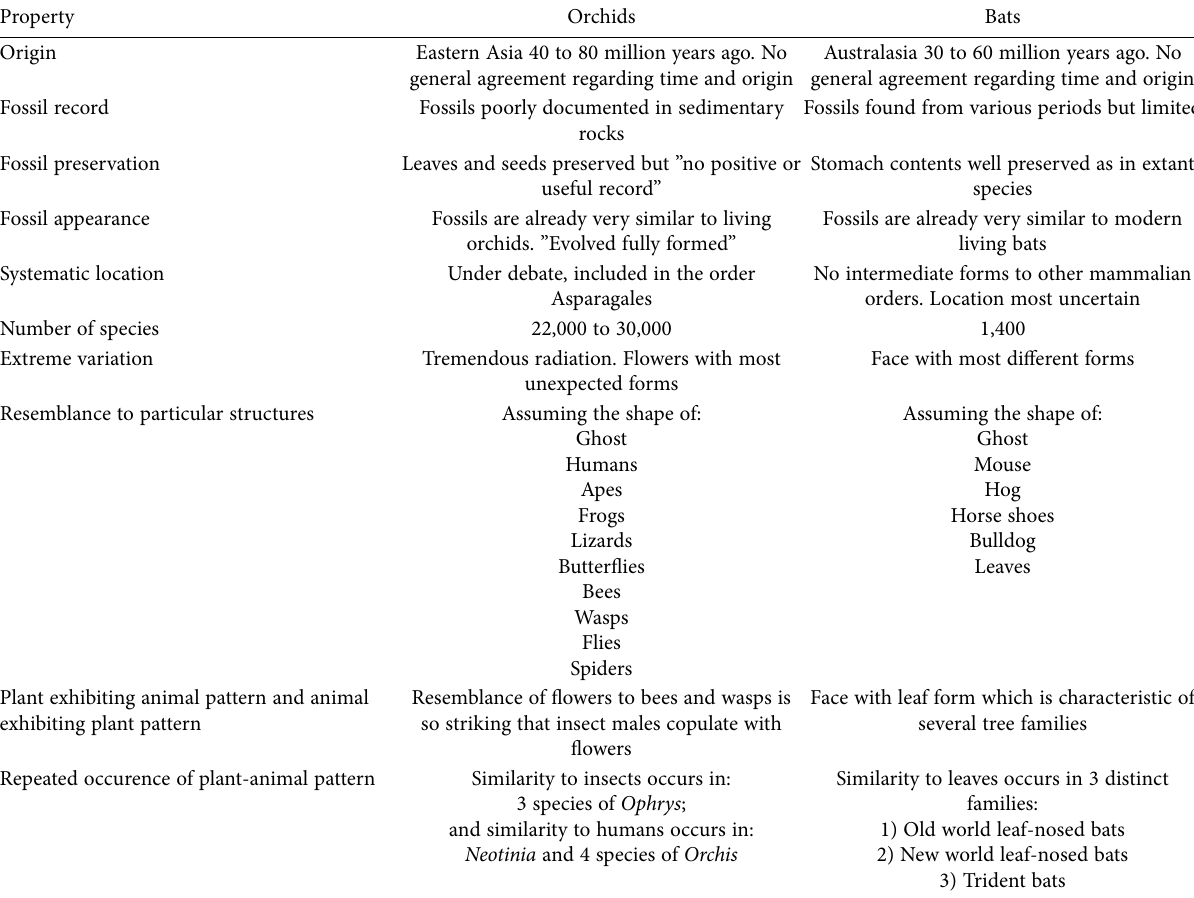
Table 4. Evolutionary similarities between orchids and bats. Property